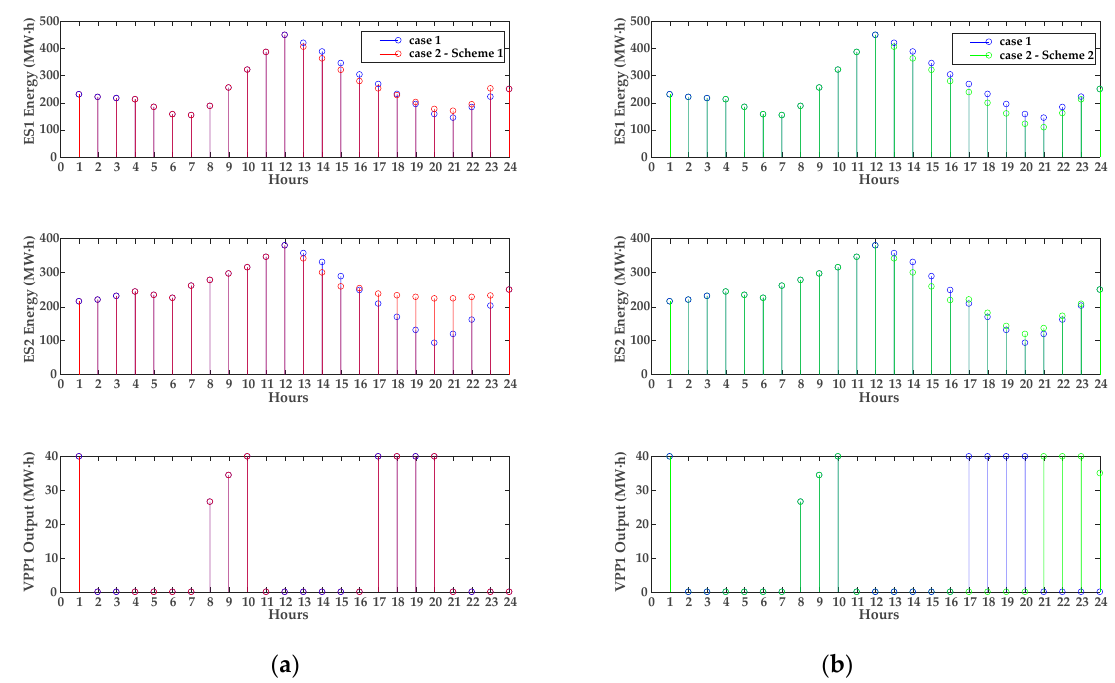
Figure 5. Comparisons of ES 1 stored energy, ES 2 stored energy, and VPP 1 output under C4 . ( a ) ES 1 stored energy, ES 2 stored energy, and VPP 1 output in case 1 and case 2 (with scheme 1); ( b ) ES 1 stored energy, ES 2 stored energy, and VPP 1 output in case 1 and case 2 (with scheme 2).